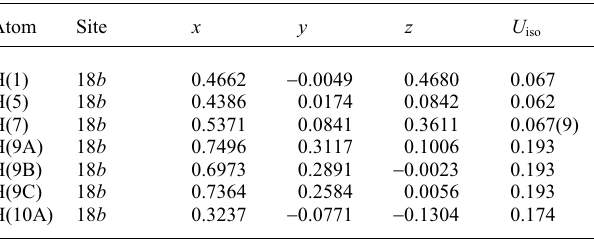
Table 2. Atomic coordinates and displacement parameters (in Å 2 )